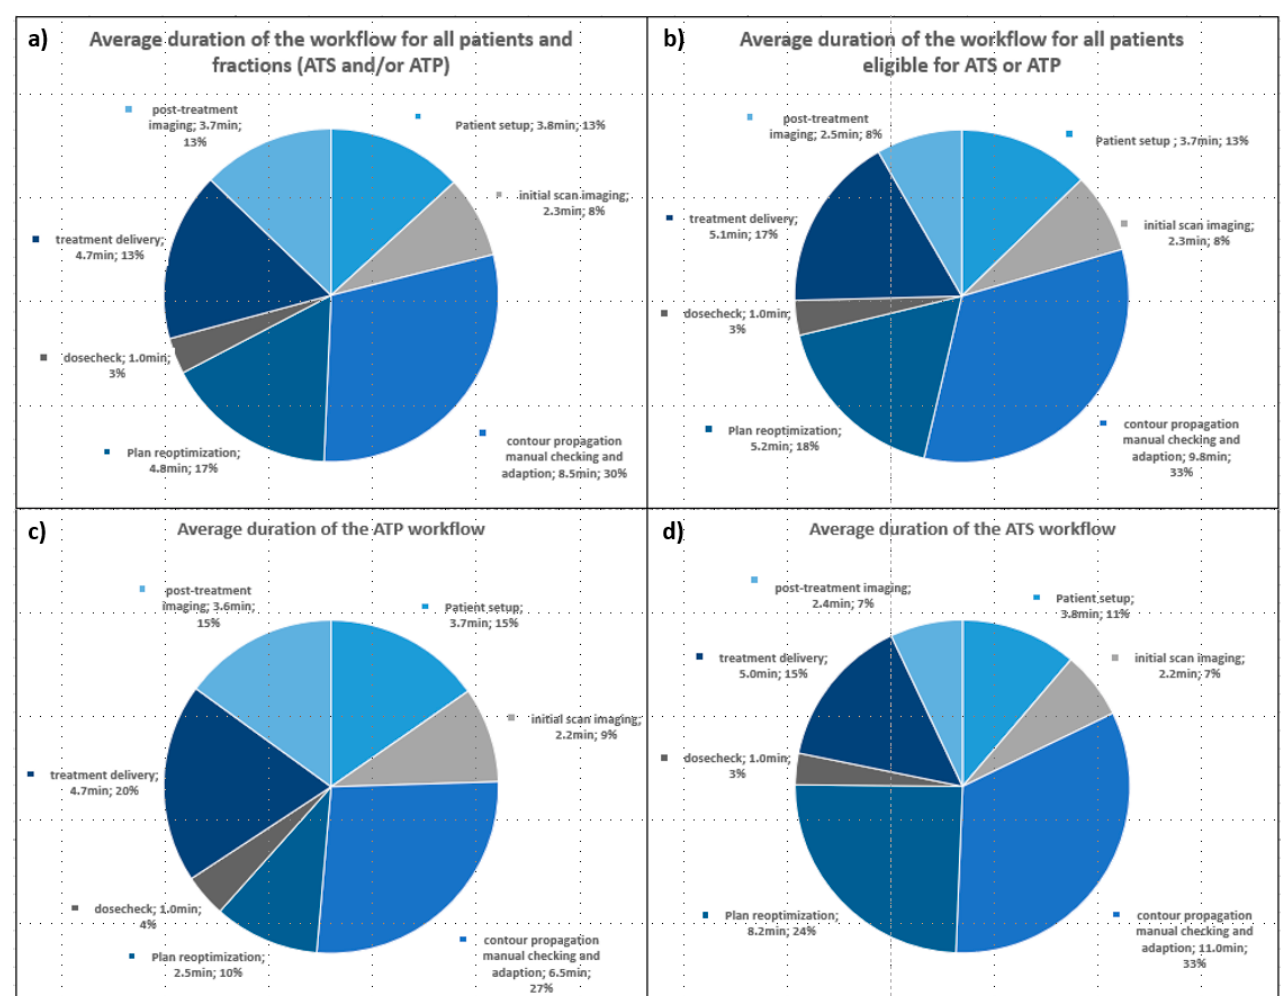
Figure 1. Diagrams of the consecutive substeps of the 1.5 T MR ‐ Linac Unity workflow with average duration per substep. ( a ) All patients 1–16, including patients 1–4 who received only ATP. ( b ) Subgroup of patients 5–16, who were eligible for ATP or ATS workflow according to the attending radiation oncologist. ( c ) All ATP fractions of all patients. ( d ) All ATS fractions of all patients. ATP = adapt to shape, rigid virtual couch shift and reoptimization, ATS = adapt to shape, recontouring and optimization. Table 3 Duration of the treatment process by subgroup.